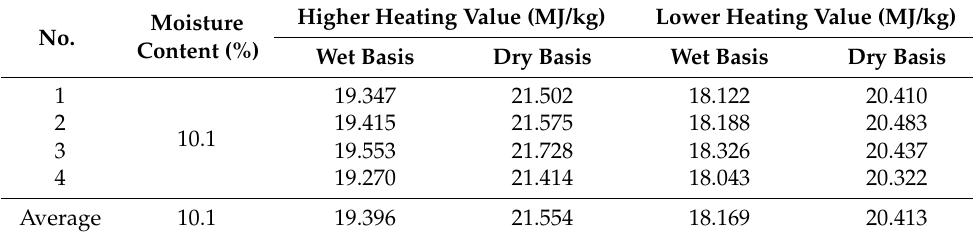
Table 1. Higher heating value and lower heating value of sage straw.